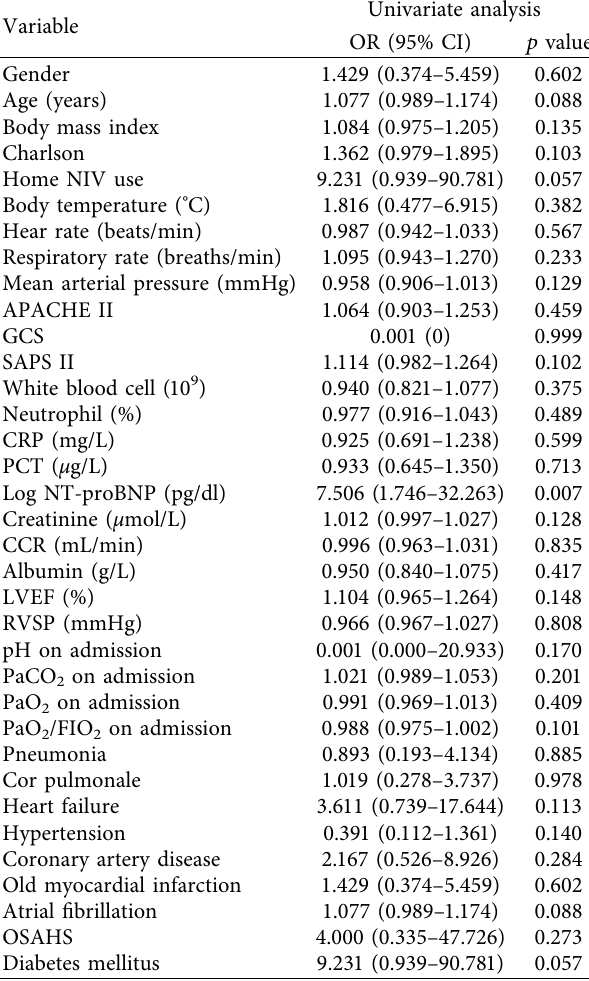
Table 6: Univariate logistic regression analysis of factors related to HFNC